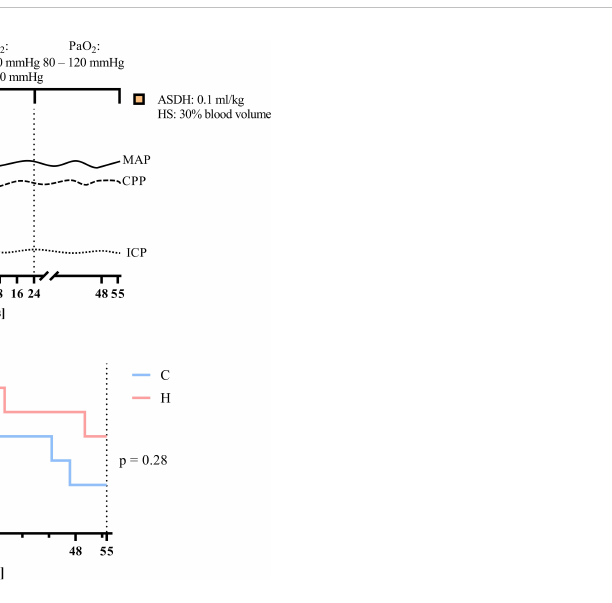
FIGURE 1 (A) Experimental setup and (B) survival analysis of animals treated with normoxemia as control (C, blue) or hyperoxemia (H, red). The dotted, dashed, or fi lled line refers to schematic trends in intracranial pressure (ICP), cranial perfusion pressure (CPP), and mean arterial pressure (MAP), respectively. Orange indicates the phase of combined hemorrhagic shock (HS) and acute subdural hematoma (ASDH). Mantel-Cox test, n = 7 per